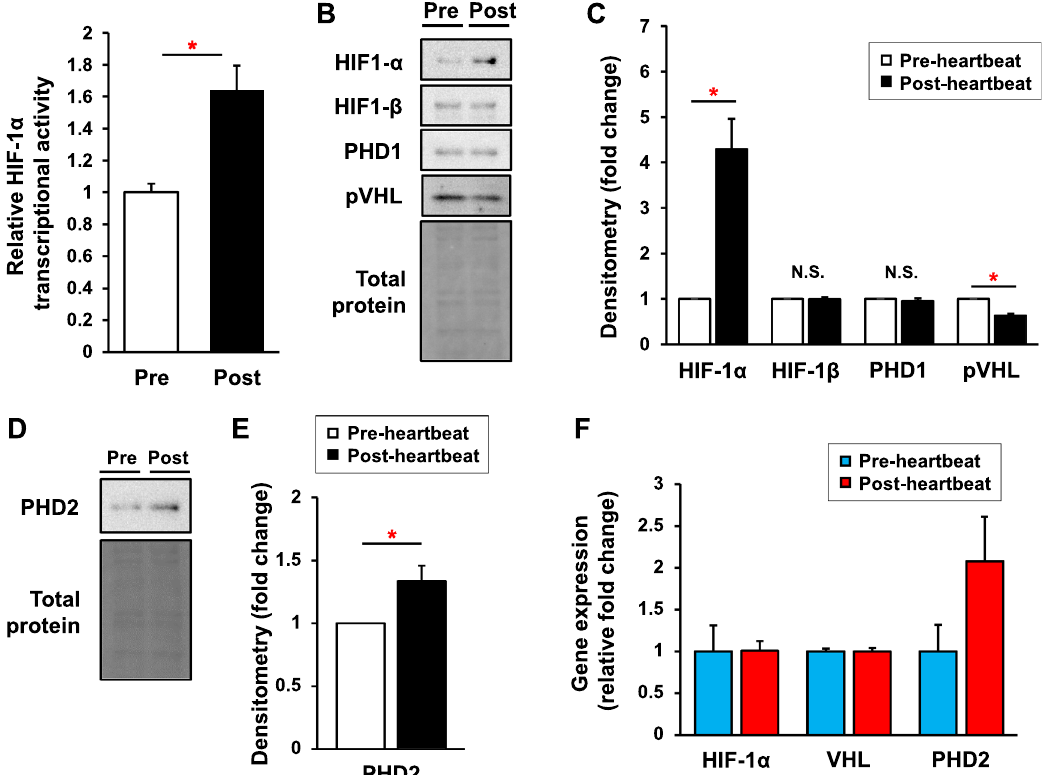
Figure 4. Activated HIF-1α with its increased protein expression in the heart primordium after heartbeat initiation. ( A ) DNA-binding activity of HIF-1α in the nuclear fraction in the pre- and post-heartbeat groups (N = 6). ( B , C ) Representative images of Western blots ( B ) and densitometry ( C ) of HIF-1α, HIF-1β, PHD1, and pVHL in the pre- and post-heartbeat group (N = 5–6). ( D , E ) Representative images of Western blots ( D ) and densitometry ( E ) of PHD2 in the pre- and post-heartbeat groups (N = 6). ( F ) Relative gene expression levels of HIF-1α, VHL, and PHD2 that were obtained by microarray analysis in the pre- and post-heartbeat groups. *p < 0.05 with Welch’s t-test. N.S.: not significant. Full-length blots/gels are presented in Supplementary Figure